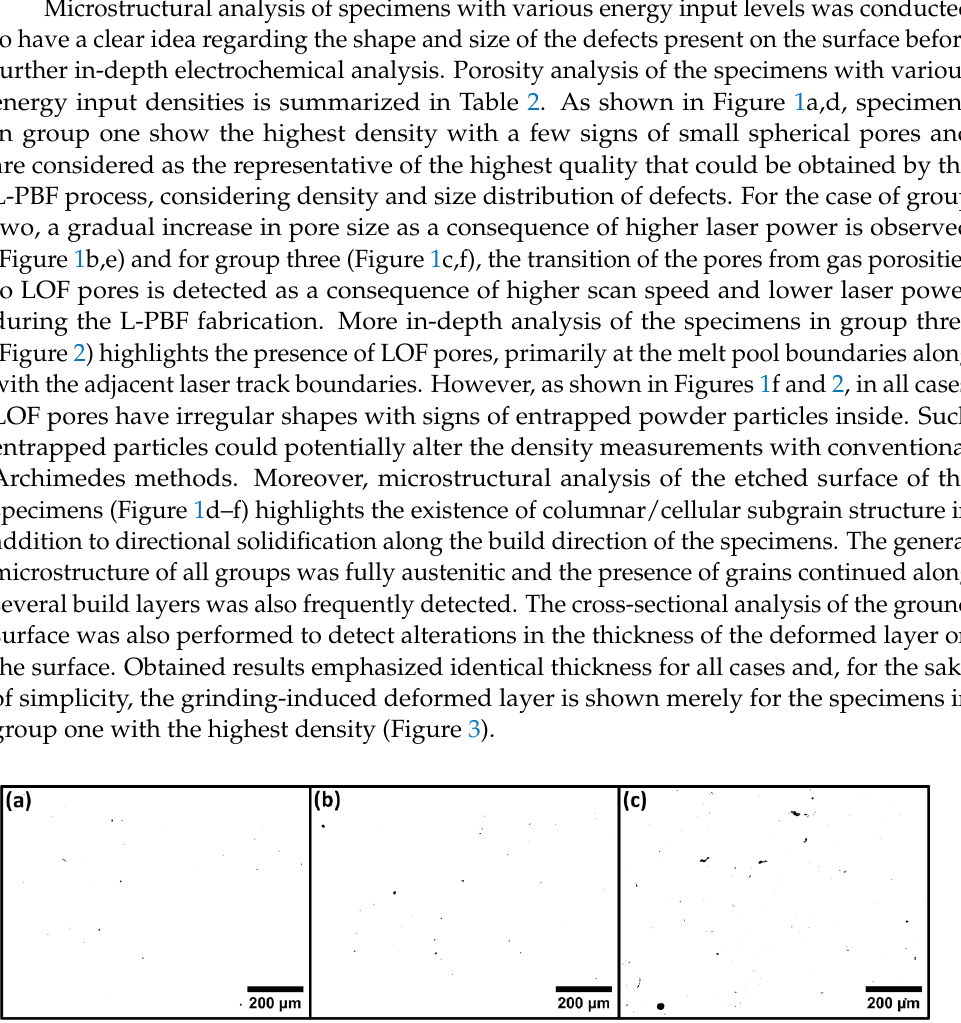
Figure 2. (a) and (b) SEM microstructural analysis of the LOF pores present in the specimens of group three. Figure 3. ( a ) Grinding-induced plastically deformed layer thickness and ( b ) surface of the ground specimens highlighting the machining marks. (BD) Build direction, (GD) grinding direction. 3.2. Residual Stress Analysis RS measurements were conducted on the surface of the specimens for both as-re- ceived polished and ground states in both longitudinal (along the machining direction) and transverse (perpendicular to the machining direction) directions, with the results pre- sented in Table 3. Specimens in the as-received polished state (after keeping untouched